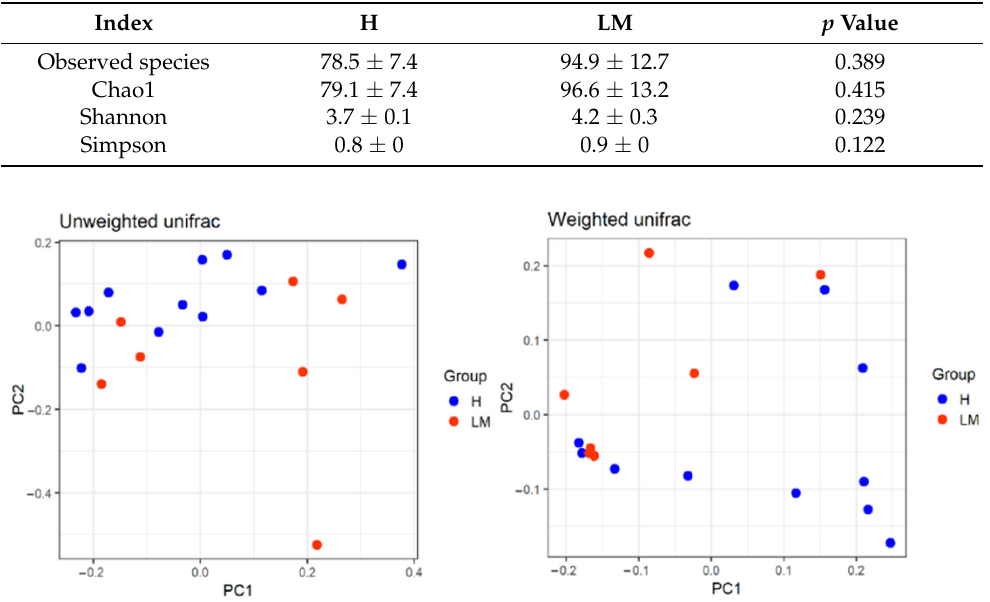
Table 2. Alpha diversity indices in healthy (H) and lymphoma (LM) groups.